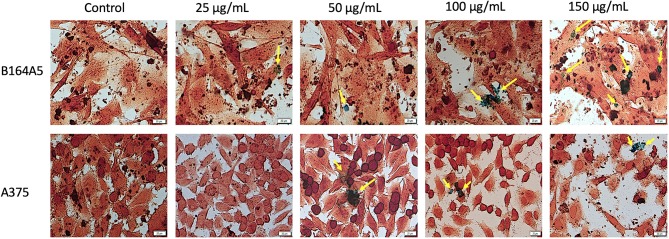
Tumor - B164A5 and A375 cells incubated with different concentrations (25, 50, 100, and 150 µg/ml) of SCMIOPs for 24 h and stained with Prussian blue reagent. Pictures were taken using Bright field (BF) microscopy. Scale bars represent 20 µm.